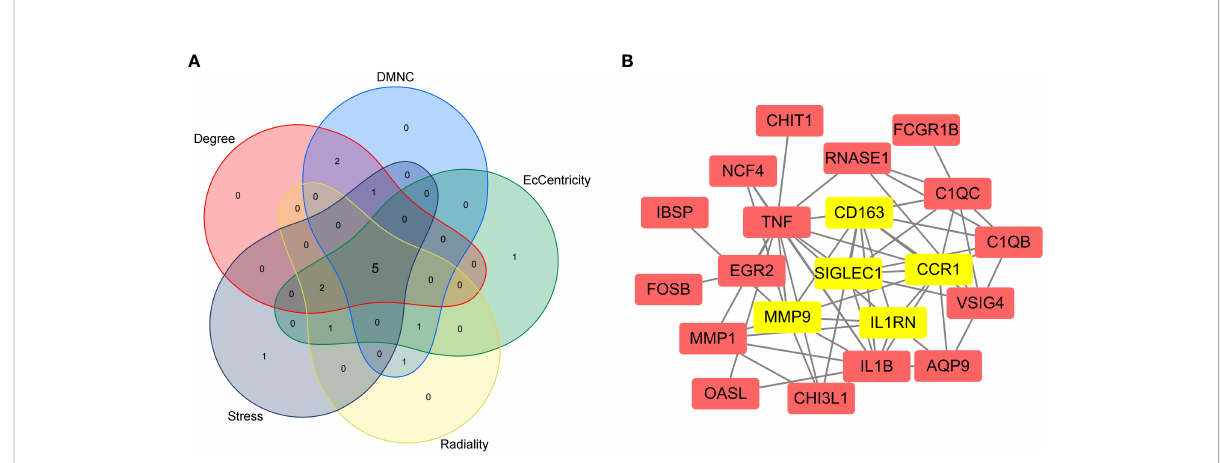
FIGURE 4 Selection of hub genes (HGs). (A) Venn diagram of the results screened by fi ve algorithms of CytoHubba. (B) Location of the fi ve HGs in the PPI